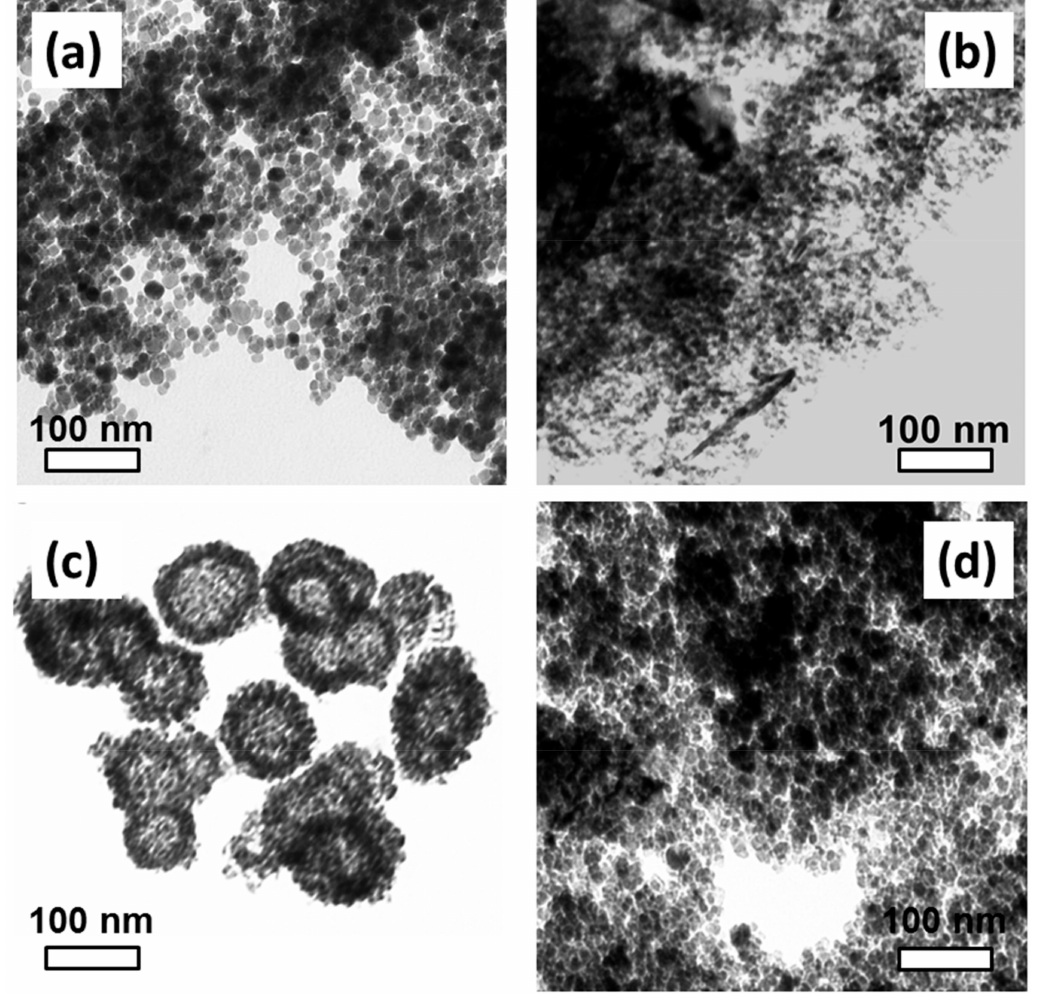
Figure 1. Transmission electron microscopy (TEM) images of samples ( a ) TD1, ( b ) TD2, ( c ) TD3, and ( d ) TD4. The TD3 nanoparticles, which were synthesized with PEG-8000 as surfactant, are self-organized in